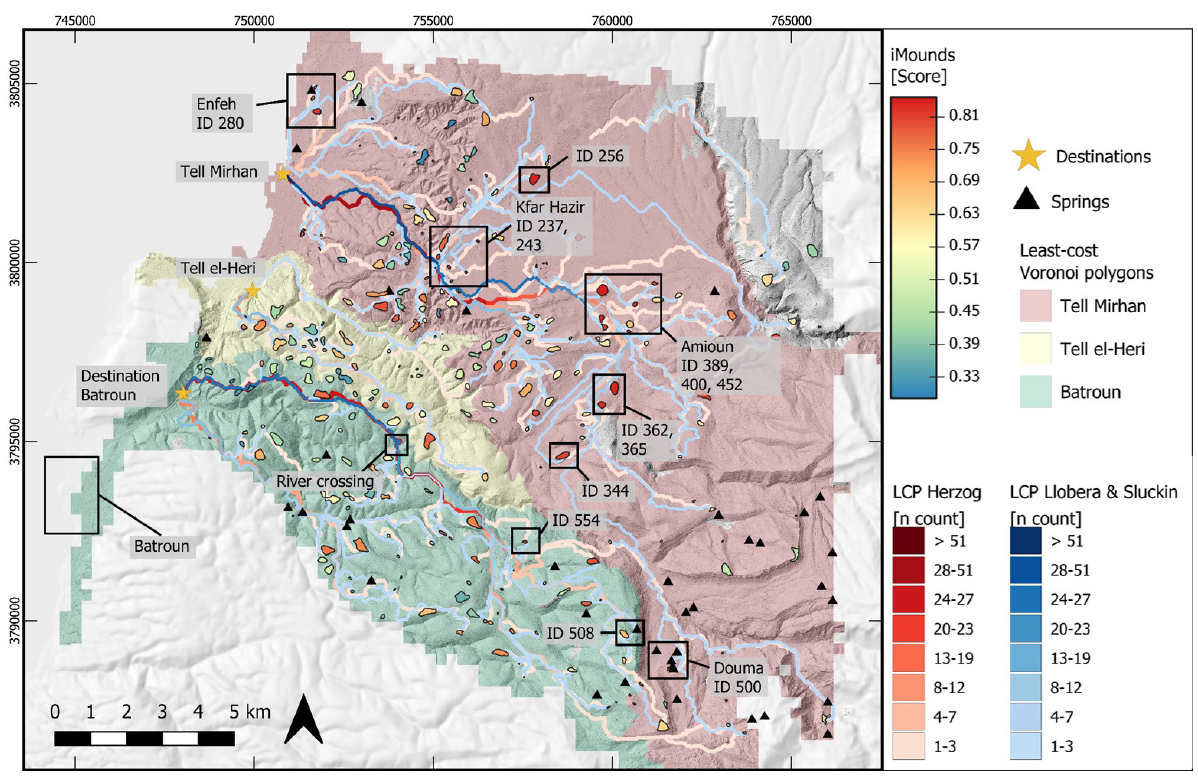
Figure 10: Results of the iMound detection and classification as well as the LCP analysis. Known springs are mapped as well. Further explanations in the